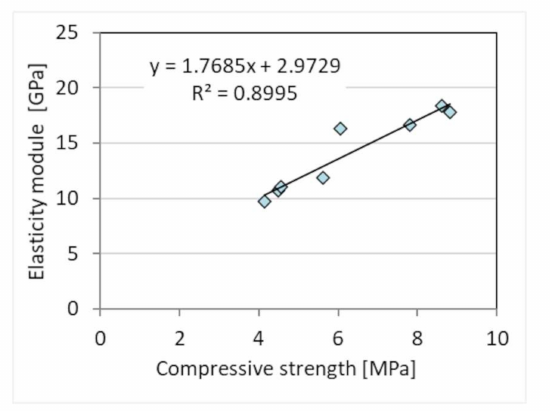
Figure 11. Relationship between dynamic elasticity modulus and compressive strength of